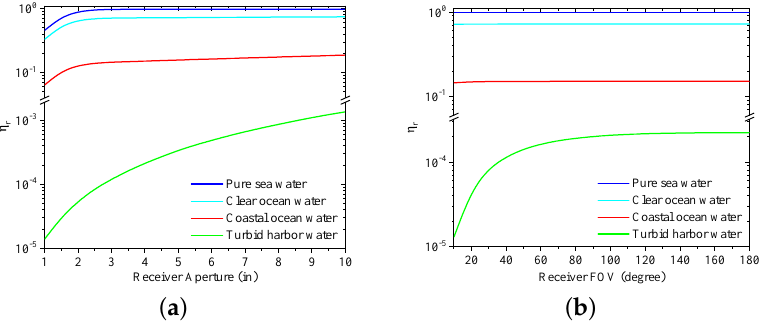
Figure 4. ( a ) η r calculated by Monte Carlo simulation versus different size of receiver aperture under four types of water. ( b ) η r calculated by Monte Carlo simulation versus different receiver FOV under four types of water.